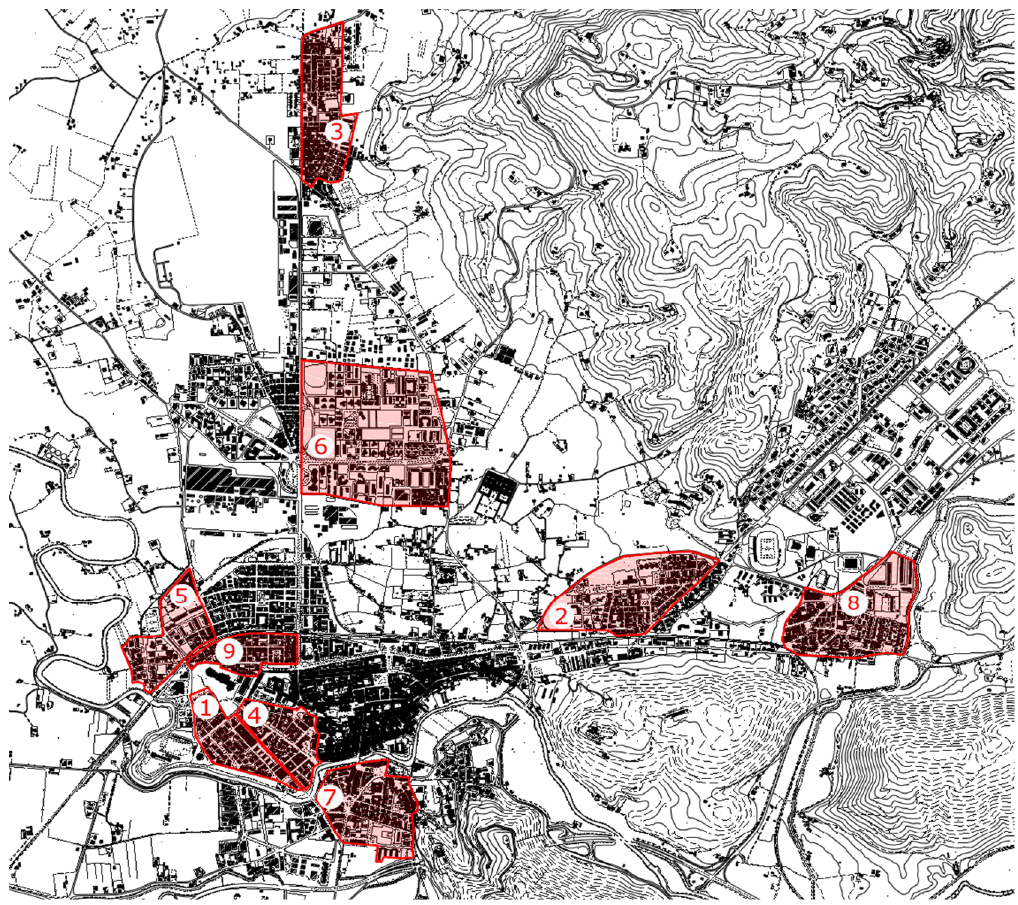
Figure 1. Rieti map. The areas in red are those included in the study. 1. Città Giardino, 2. Piazza Tevere, 3. Quattro Strade, 4. Fiume dei Nobili, 5. Molino della Salce, 6. Micioccoli, 7. Borgo S. Antonio, 8. Villa Reatina, 9. Viale dei Flavi.